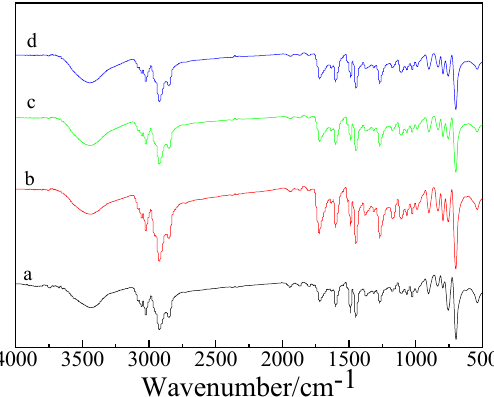
Figure 1. FTIR of the resin before ( a ) and after ( b ) La(III) or ( c ) Ce(III) or ( d ) Y(III)